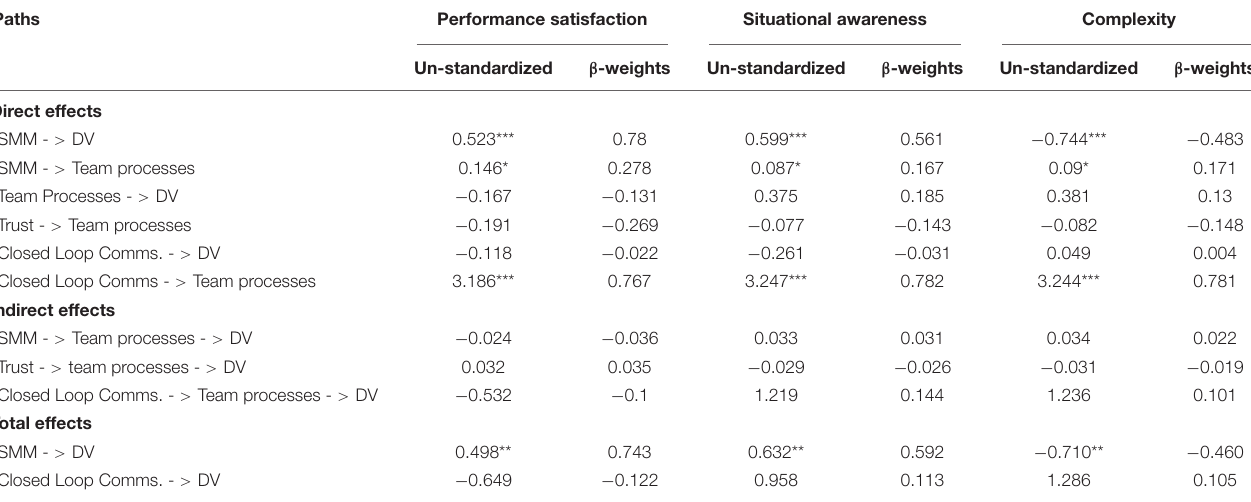
TABLE 3 | Regression weights for the proposed paths in the model predicting the three dependent variables (DV) of subjective evaluation of performance satisfaction, situational awareness, and mission complexity (complexity).